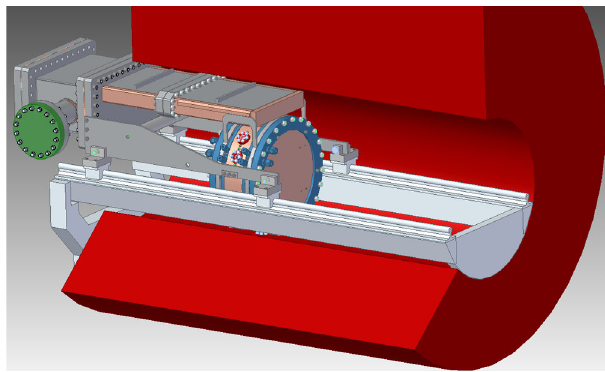
FIG. 7. Cavity mounted in MTA solenoid bore. False colors indicate: cut view of MTA solenoid (red); support rails (silver); vacuum pumping port (dark green); rf pickup and instrumentation ports (red).